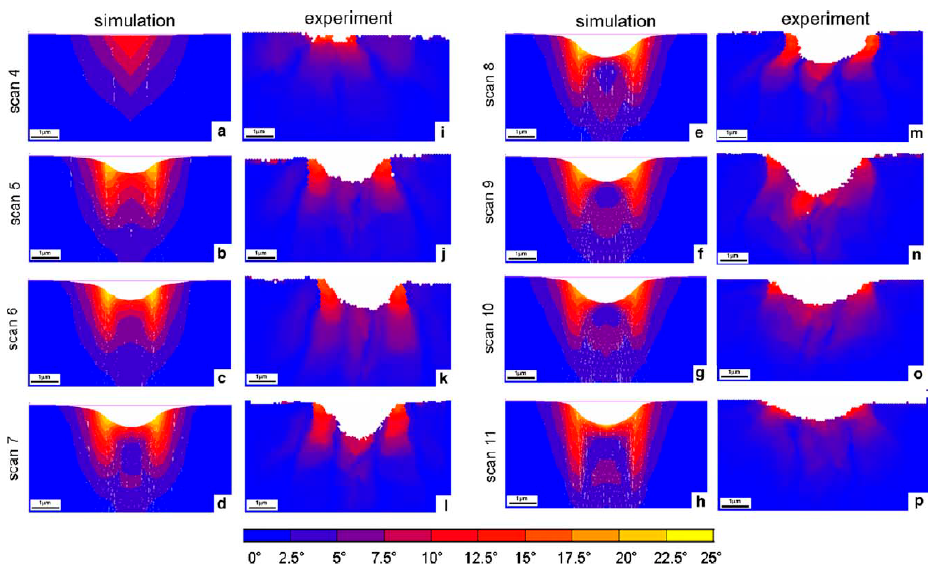
Figure 37. Rotation maps for a set of successive (112) sections perpendicular to the (111) indentation plane (surface plane perpendicular to the plane presented) with different spacing to the actual indent [45]. The images on the left-hand side ( a – h ) were obtained from viscoplastic crystal plasticity simulations. The corresponding maps on the right-hand side ( i – p ) were determined via EBSD measurements in succeeding planes prepared by serial FIB sectioning. The color code shows the magnitude of the orientation change relative to the initial crystal orientation without indicating the rotation axis or rotation direction. Scaling is identical for all diagrams. Reproduced with permission from N. Zaafarani et al., Acta Materialia; published by Elsevier,